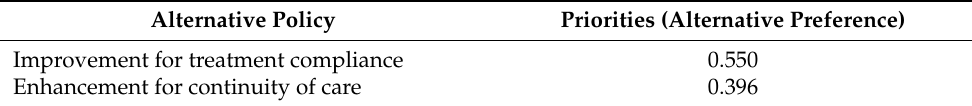
Table 5. Priorities by alternative policy (alternative